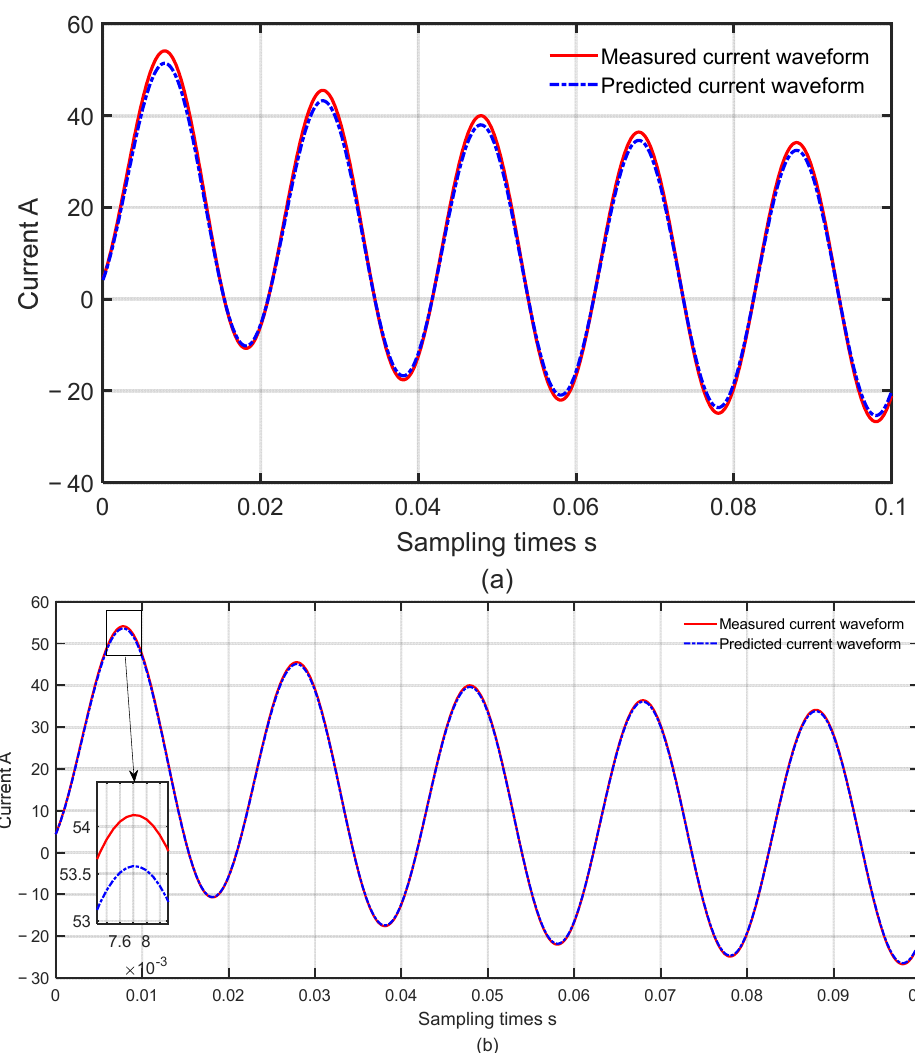
Figure 9. Comparison of measured and predicted waveform. ( a ) Forecast results without trend filtering technique. ( b ) Forecast results without trend filtering technique.